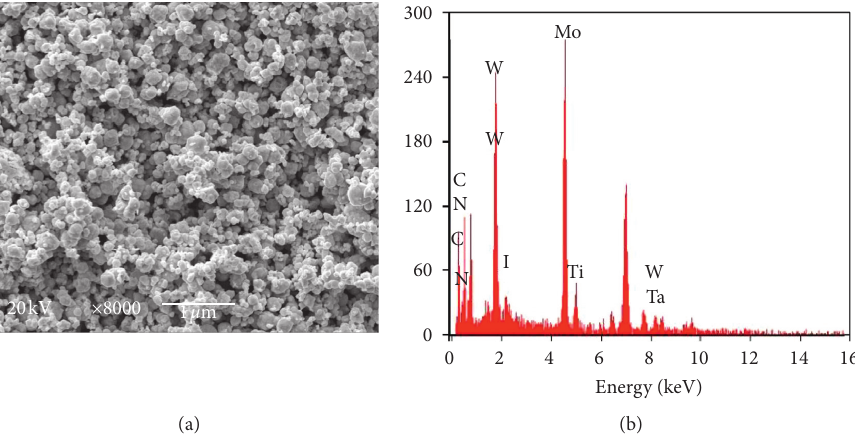
Figure 6: SEM and EDS images of (Ti, Ta, Mo, W) (C, N) solid solution powder prepared at 1500 °